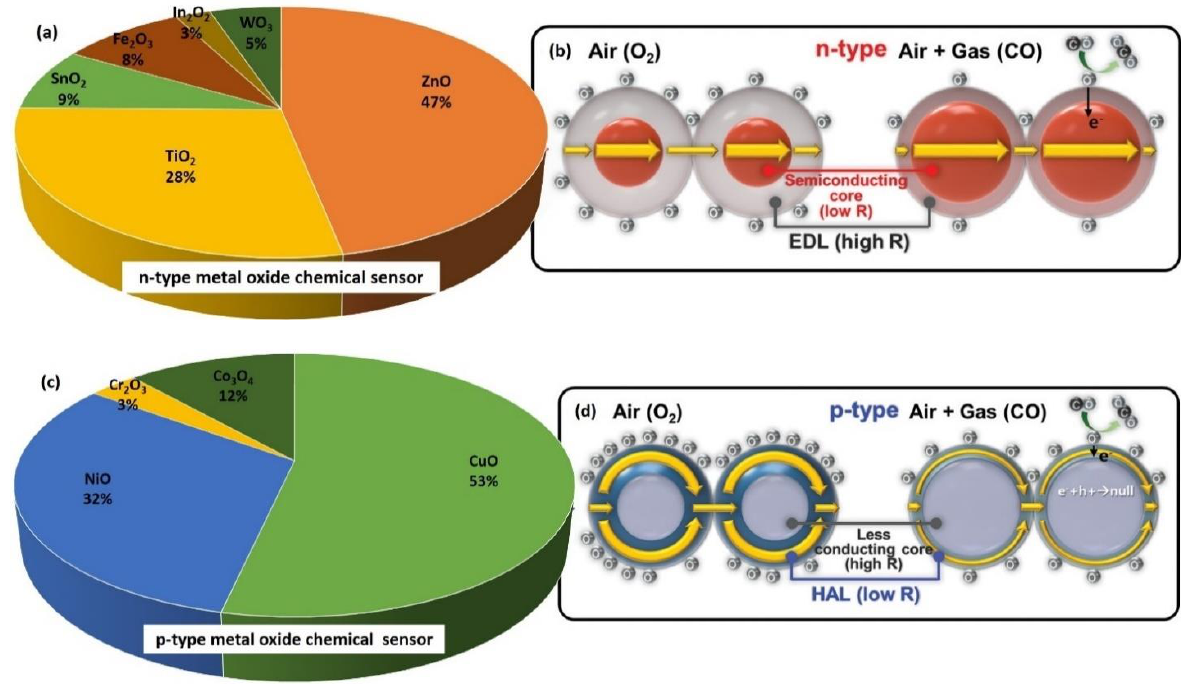
Figure 5. Search study on ( a ) n -type and ( c ) p -type metal oxides as gas sensors from 2020 to 2021, ( b , d ) gas-sensing mechanisms of n -type and p -type metal oxide chemical sensors. Reproduced from ref. [97].